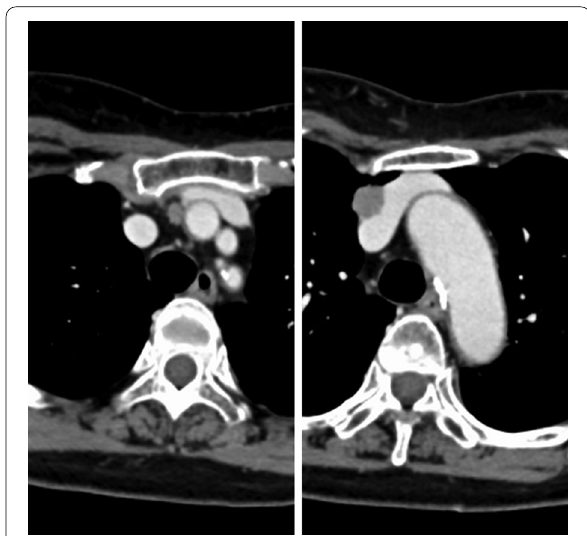
Fig. 1 Chest computed tomography (CT) revealed a recurrent lesion in the anterior mediastinum